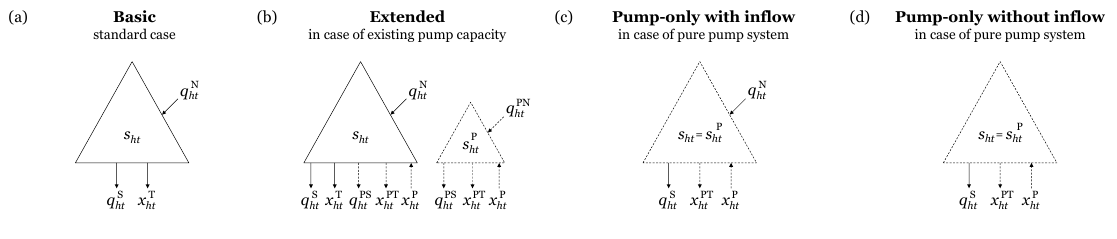
Figure 5. Four equivalent hydro system model